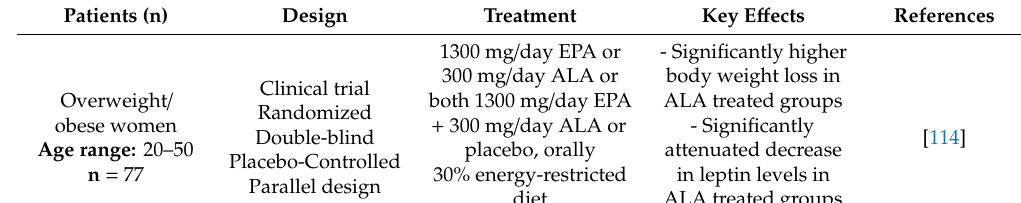
Table 2. E ff ects of ALA in overweight / obese